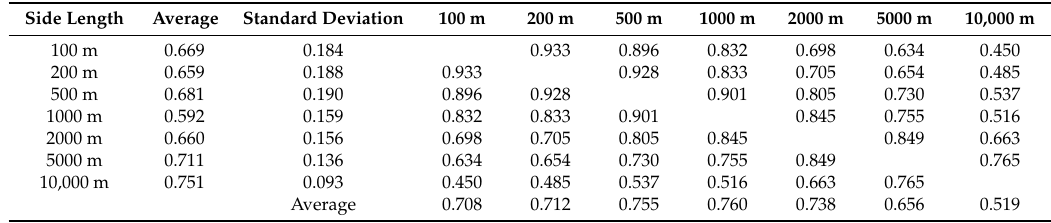
Table 8. Correlation matrix and basic statistic parameters for the 5000 m mesh control points grid. Side Length